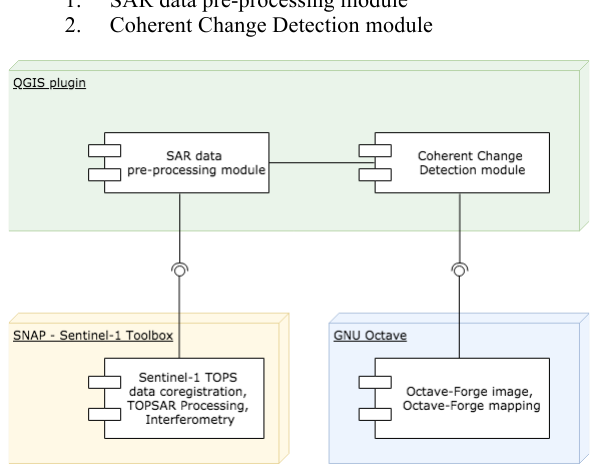
Figure 2. Component diagram of the processing pipeline The output of the Coherent Change Detection module, a CSV file containing, for each detected change, the WGS84 coordinates, the value of change statistics, and the date, is automatically imported in QGIS as a Delimited Text Layer using the QgsVectorLayer class of the QGIS API. The final result of the pipeline is a graphical visualization of the change detection map, as it will be observed in Section 4.